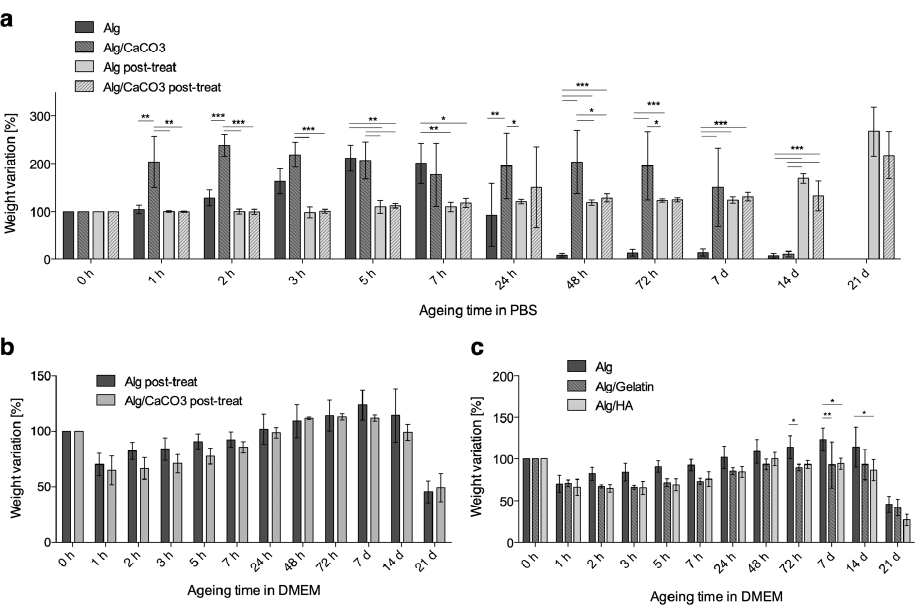
Figure 5. Percentage weight variation after ageing in ( a ) Phosphate Buffer Saline (PBS) and in ( b